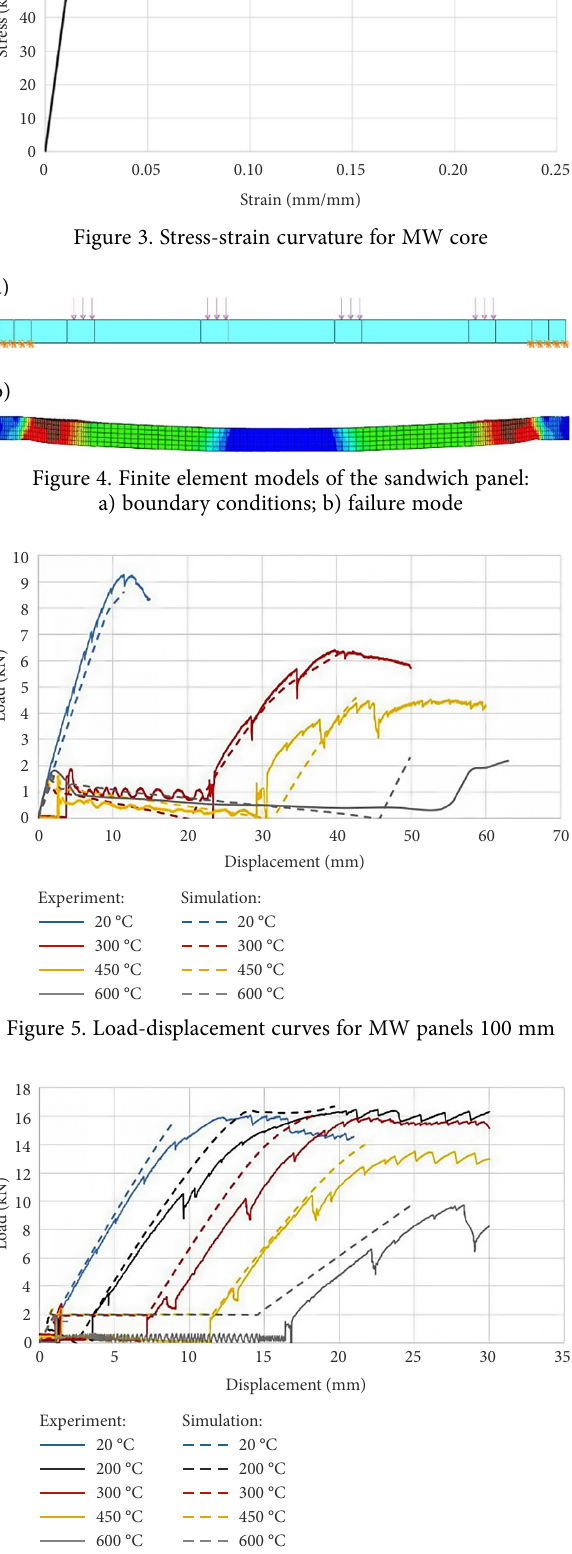
Figure 6. Load-displacement curves for MW panels 230